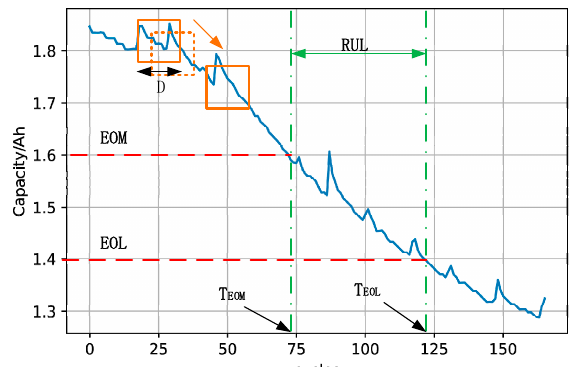
Figure 4. Process of RUL prediction.